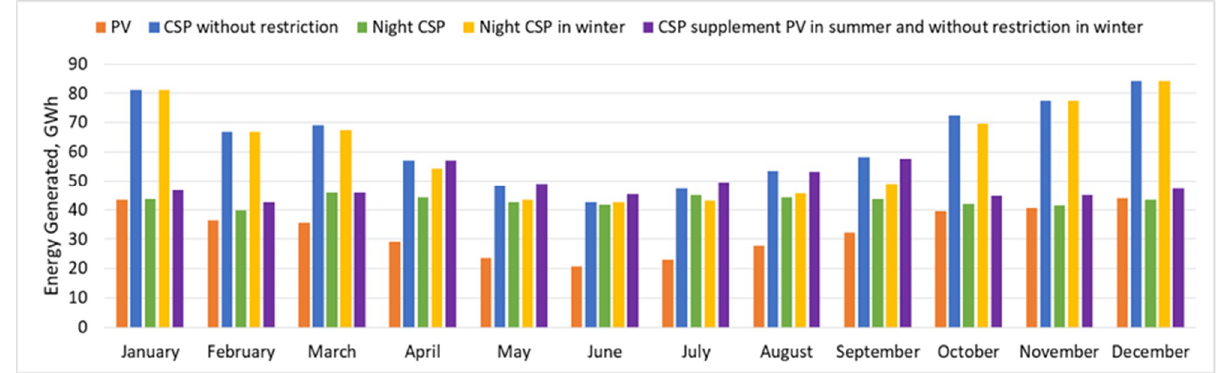
Figure 8. Annual energy generation for each plant according to the month of the year (CSP with 13 h of storage).